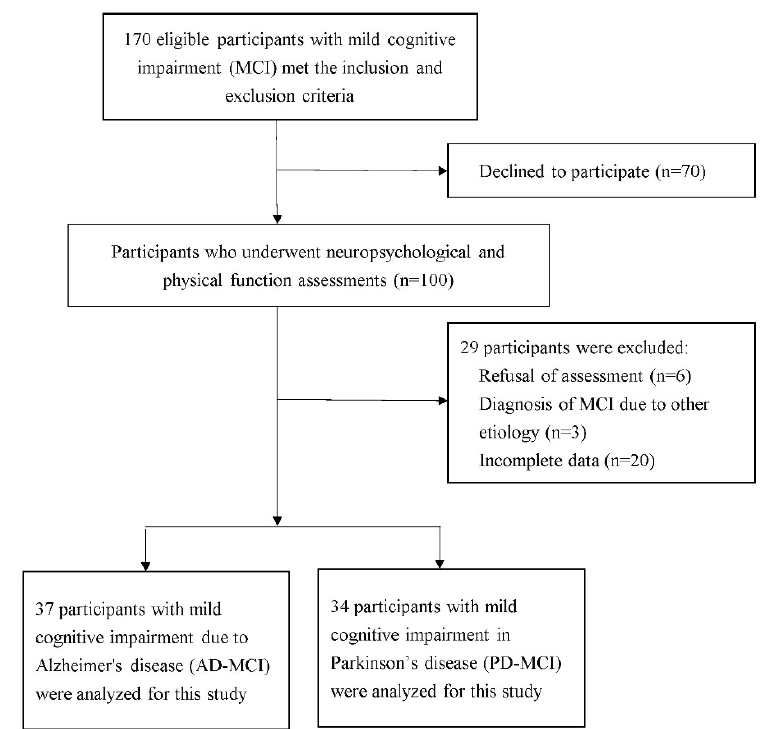
Figure 1. Flow chart showing the process of selecting subjects in this study.